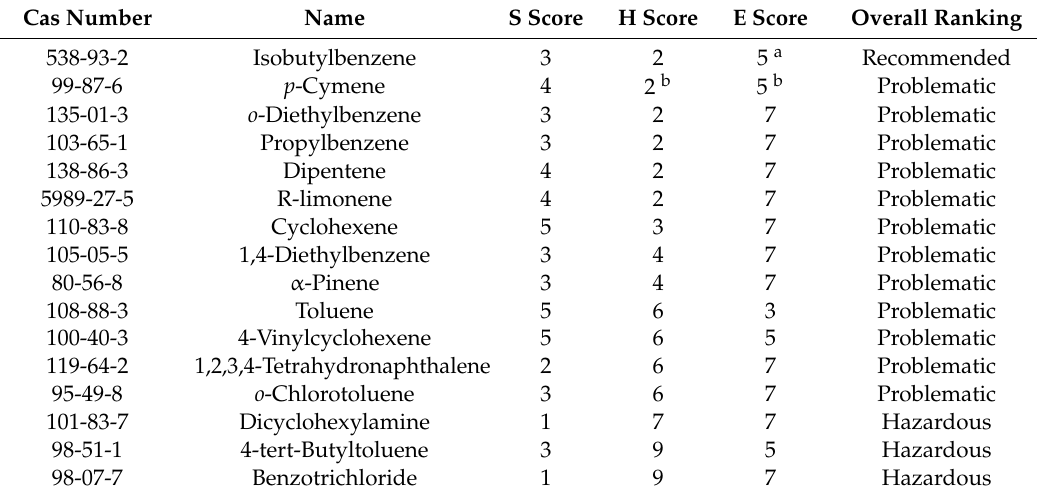
Table 2. Short list with solvent replacement candidates for toluene in a contact